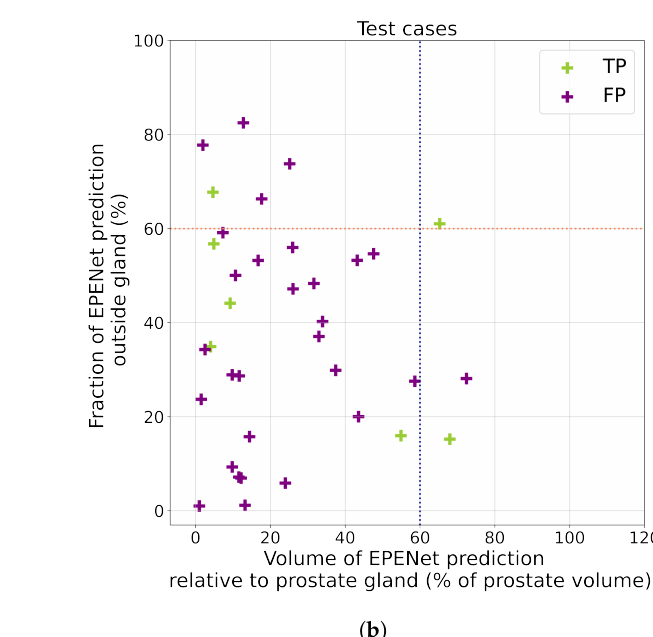
Figure A2. True and false predictions, with ground truth information about cancer and EPE lesion volumes. The x -axis shows the volume of cancer inside the prostate as a percentage of the total prostate gland volume. The y -axis shows the volume of extraprostatic extension as a percentage of the total prostate gland volume. Cases which are ground truth negative for EPE therefore have coordinate y = 0. ( a ) All training set cases. ( b ) Training set, zoomed-in view on the cases with small cancer and EPE volumes. ( c ) All test set cases. ( d ) Test set cases, zoomed-in view on the cases with small cancer and EPE volumes.